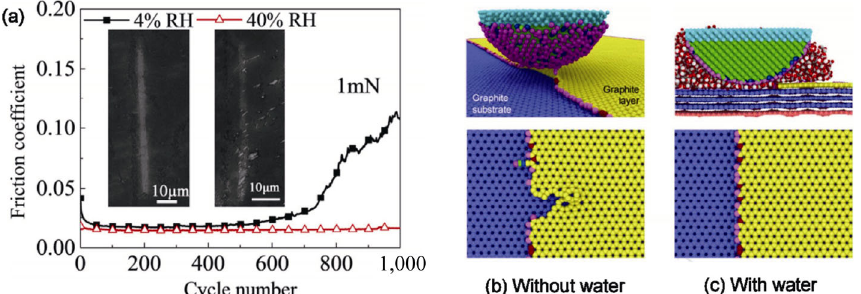
Fig. 16 RH-dependent wear of graphene in experiments and MD simulations. (a) Friction and wear behaviors of graphite in humid air with RH values of 4% and 40%. Reproduced with permission from Ref. [165], © Elsevier 2017. (b, c) wear of graphene step edge against a diamond tip under conditions without and with water in MD simulations, respectively. Reproduced with permission from Ref. [172], © Elsevier 2018.